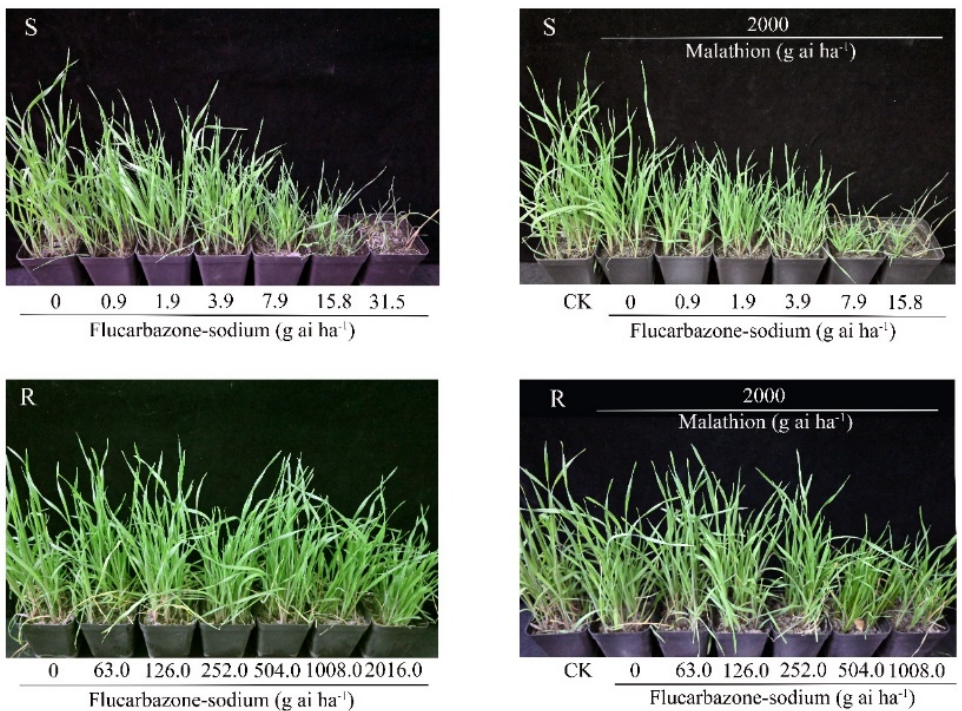
Figure 1. Whole-plant dose-response analysis of the resistance to flucarbazone-sodium and to flucarbazone-sodium with malathion in the S and R B. japonicus populations at 21 DAT.